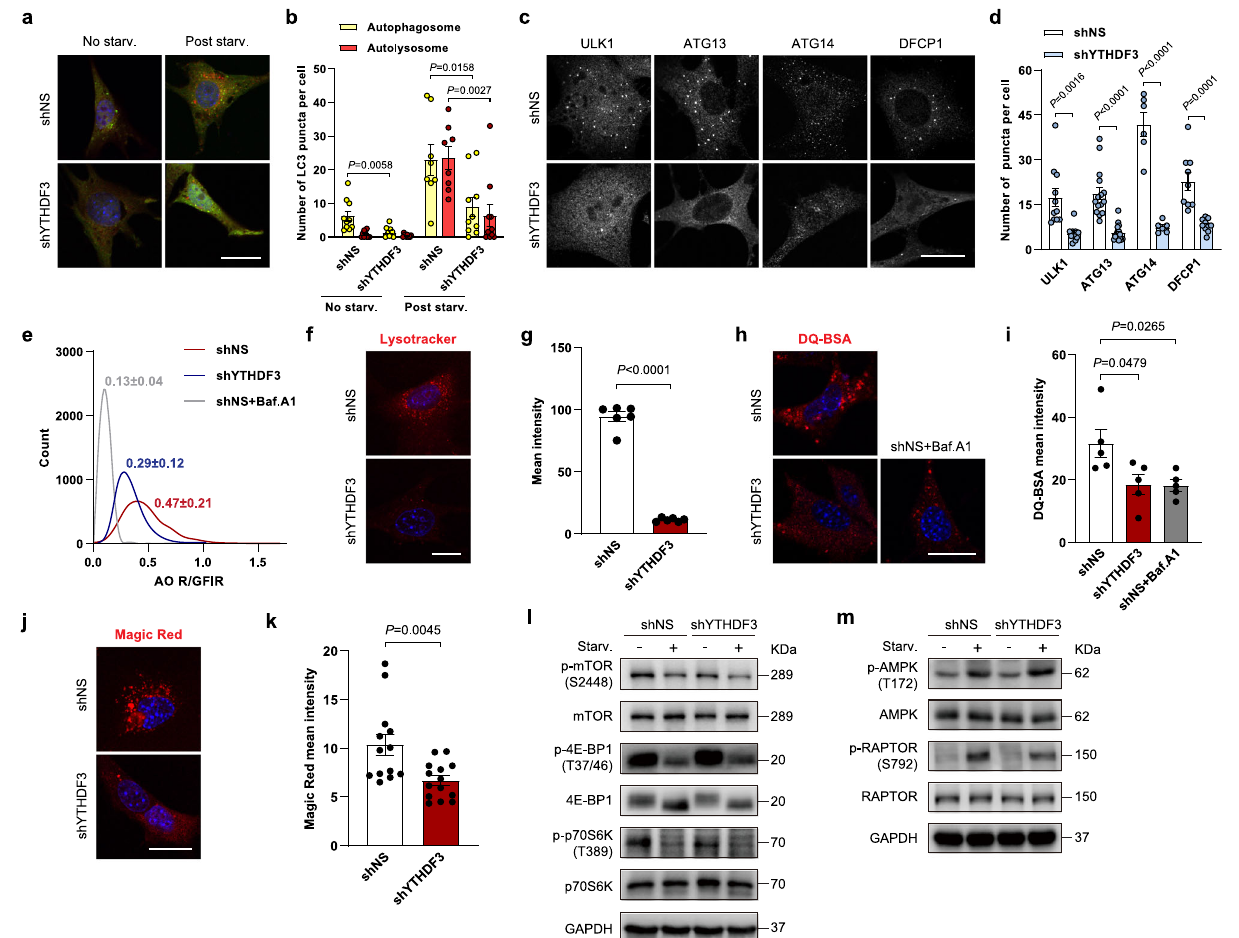
Fig. 2 | YTHDF3 depletion impairs autophagosome formation and lysosomal function. a , b mCherry-GFP-LC3 was transfected into shNS and shYTHDF3 MEFs, and autophagosome (yellow) and autolysosome (red) formation was examined. Scalebar, 20 μ m. c , d Endogenous ULK1, ATG13,ATG14,and DFCP1punctainshNS andshYTHDF3MEFswereimmunostainedafternutrientde fi ciency,visualizedwith confocal microscopy ( c ), and quanti fi ed ( d ). Scale bar, 20 μ m. e Histograms of R/ GFIR of 3000 events analyzed by fl ow cytometry after AO staining in shYTHDF3 MEFs and shNS MEFs, with or without 20nM Baf.A1 for 4h. Values above the his- togram indicate mean R/GFIR±SEM of three experiments. f , g Representative images ( f ) and quanti fi cation ( g ) of total LysoTracker Red in shNS and shYTHDF3 MEFs. Scale bar, 20 μ m. h , i Representative images ( h ) and quanti fi cation ( i ) of intracellular proteolysis by DQ-BSA in shYTHDF3 MEFs and shNS MEFs, with or without 20nM Baf.A1 for 4h. Scale bar, 20 μ m. j , k Live imaging of Magic Red dye,